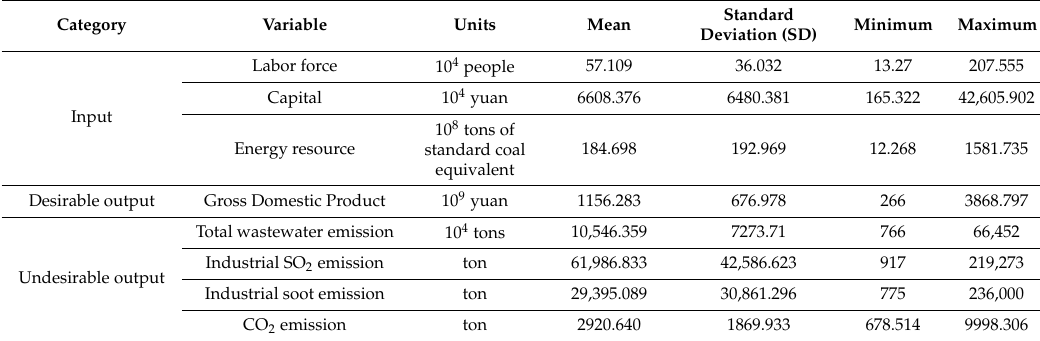
Table 1. Input and output indicator statistics, 2007–2018. n =